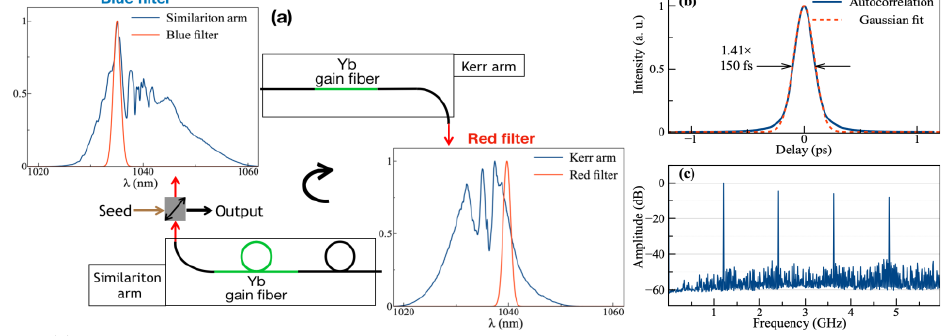
Fig. 1 (a) Schematic representation of our laser, showing the filters and the incident spectra for the 1.2 GHz state.